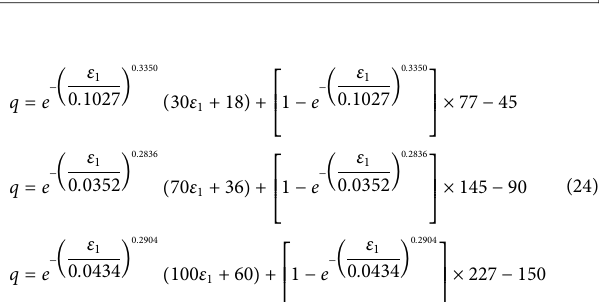
FIGURE 9 | Comparison between model calculation curve and data in reference Zhu and Xiao-qiang,